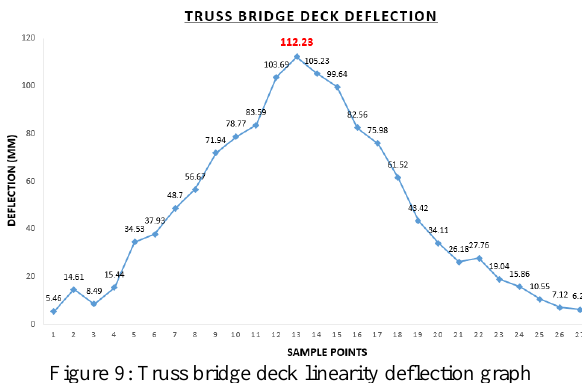
Figure 8: Truss Bridge deck linearity deflections All the deflections obtained are shown in the graph format to easily identify the maximum deflection through out the deck. No support was present except the abutments at either ends of Truss Bridge deck.